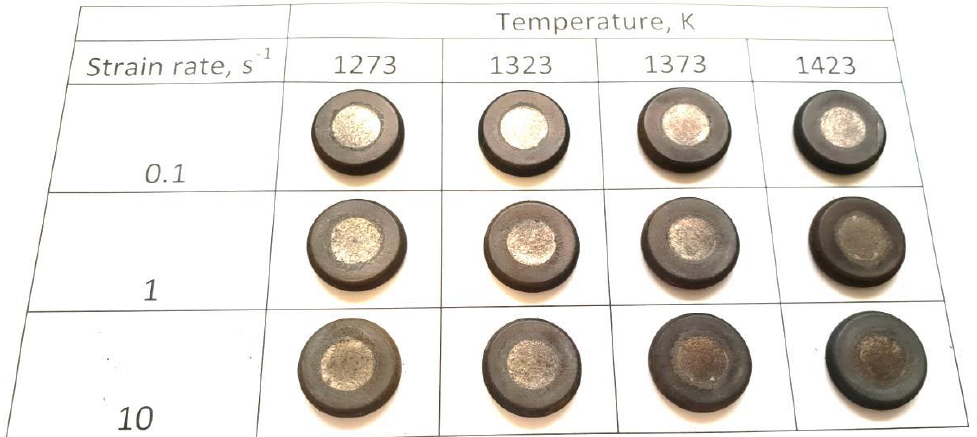
Figure 3. The images of the samples after hot deformation.